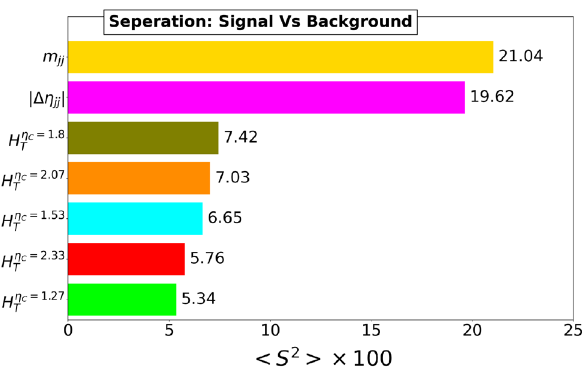
Fig. 7 The separation of the 7 highest performing variables (given in percentage) E denotes the set of chosen η the interval